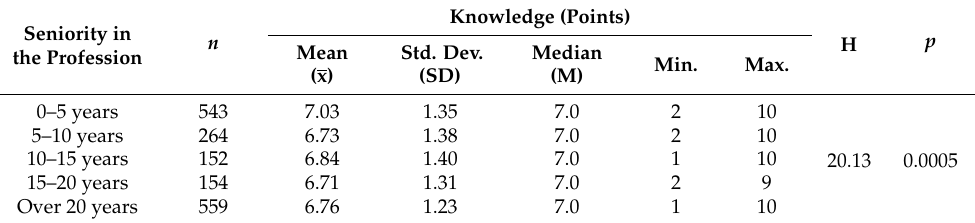
Table 4. Descriptive statistics of the level of knowledge among respondents with various lengths of work in the profession and the result of the Kruskal–Wallis test